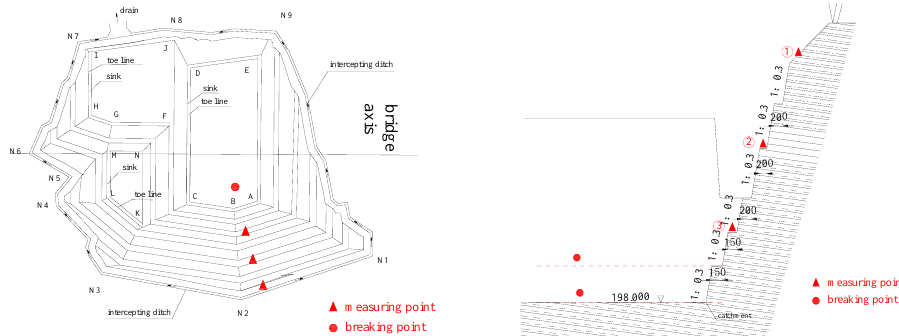
Figure 28. Location of blasting vibration monitoring point.